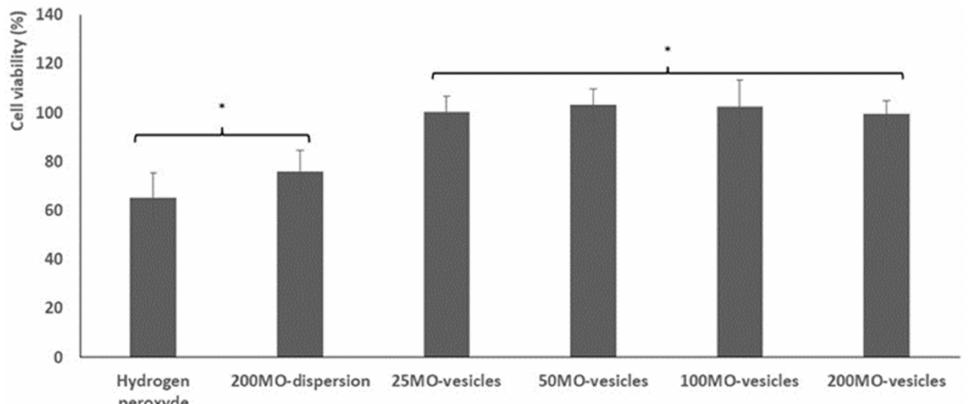
Figure 5. Viability of cells stressed with hydrogen peroxide and treated with the dispersion containing quercetin and mint oil (200 mg/mL) or with the vesicles loading quercetin and mint oil (25, 50, 200, 200 mg/mL) properly diluted. Mean values (bars) ± standard deviations were reported ( n = 8). The same symbol (*) indicates the same